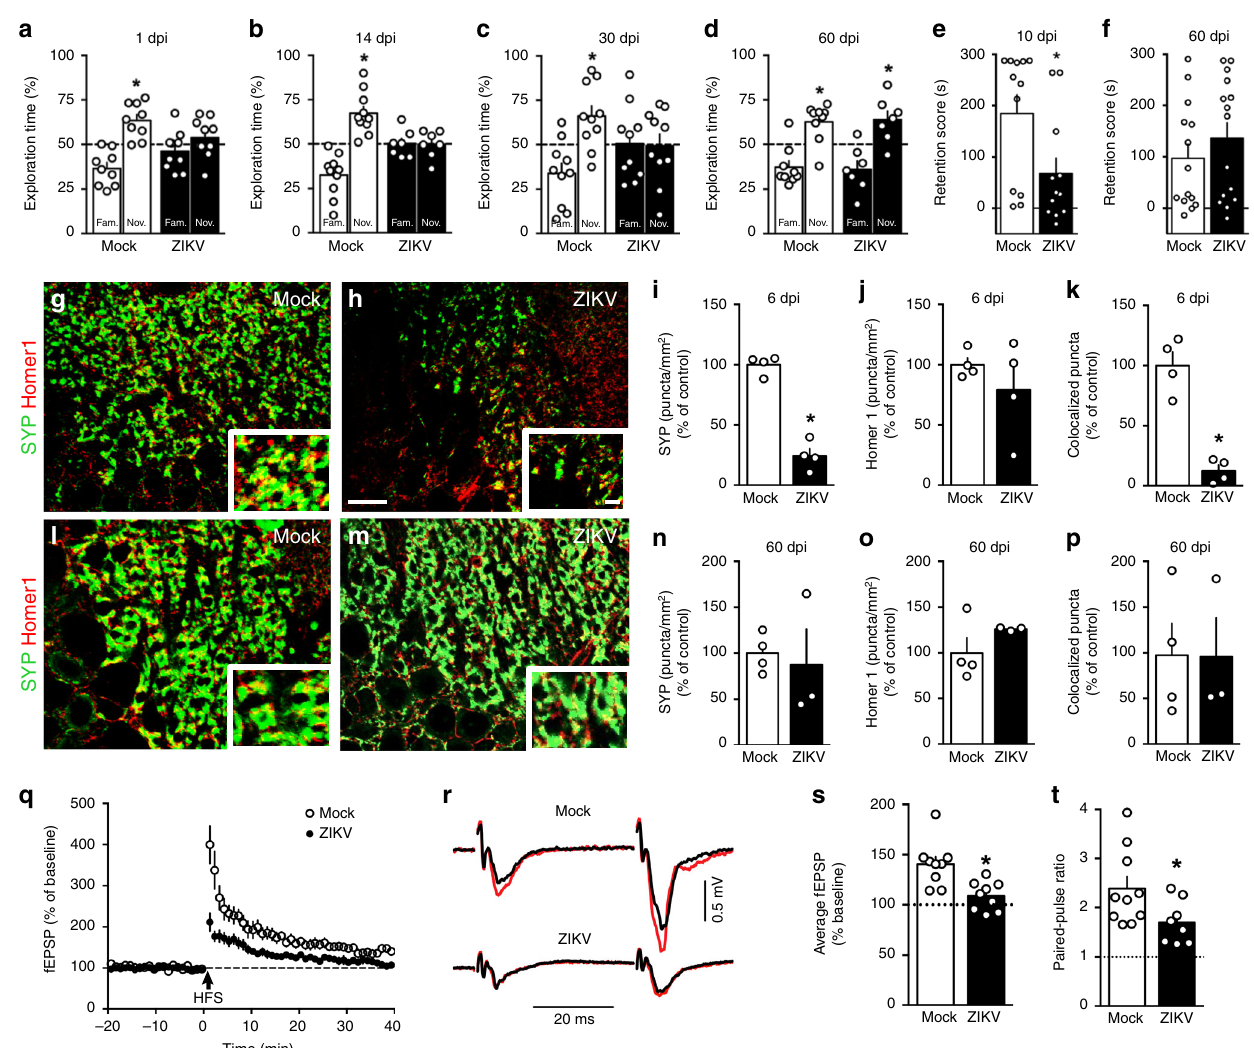
Fig. 3 ZIKV causes synapse damage and memory impairment in mice. Adult mice received an i.c.v. infusion of 10 5 PFU ZIKV or mock medium. a – d Independent groups of mice were tested in the novel object recognition (NOR) test at 1 dpi ( a t = 4.553; * p = 0.0014; N = 10 mice/group), 14 dpi ( b t = 4.587; * p = 0.0013; N = 10 (mock), and 7 (ZIKV)), 30 dpi ( c t = 2.714; * p = 0.0239; N = 10 mice/group), or 60 dpi ( d t = 3.525; * p = 0.0078 for mock- infused; t = 2.907; p = 0.0271 for ZIKV-infected mice; N = 9 (mock) and 7 (ZIKV)); one-sample Student ’ s t -test compared to fi xed value of 50%. e , f Mice were tested in the step-down inhibitory avoidance test at 10 dpi ( e t = 2.476; * p = 0.0215; Student ’ s t -test; N = 12 mice/group) or 60 dpi ( f N = 14 (mock) and 15 (ZIKV)). a, b, c , e represent one of two independent experiments. Representative images of the CA3 hippocampal region of mock-infused ( g, l ) or ZIKV-infected mice ( h, m ) at 6 ( g , h ) and 60 ( l, m ) dpi, immunolabeled for synaptophysin (SYP, green) and Homer1 (red). ( i – k , n – p ) Number of puncta for SYP ( i ), Homer1 ( j ), and colocalized SYP/PSD-95 puncta ( k ). ( i t = 10.46, * p < 0.0001; k t = 6.009, p = 0.0004, Student ’ s t -test; N = 4 mice/group; n – p N = 4 (mock) and 3 (ZIKV)). Scale bar = 25 µ m; inset scale bar = 5 µ m. q – t ZIKV infection impairs LTP induction in dorsal hippocampal CA3 area. q Plot shows means ± SEM of the slopes of fi eld excitatory post-synaptic potentials (fEPSPs) evoked in CA3 by mossy fi ber stimulation, before and after high- frequency stimulation (HFS), in acute slices from mock- or ZIKV-infected mice. r Representative fEPSPs recorded before (black traces) and 35 – 40 min after (red traces) HFS. s Average fEPSP slopes 35 – 40 min post-HFS. t Baseline paired-pulse amplitude ratios. ( N = 10 slices from 8 mock-infused and 8 slices from 5 ZIKV-infected mice; s: t = 2.733, * p = 0.015; t: t = 2.228 * p = 0.041; Student ’ s t -test). Bars represent means ± SEM. Symbols represent individual mice ( a – p ) or individual slices ( s – t ). Source data from panels a – f , i – k , n – t are provided as Source Data